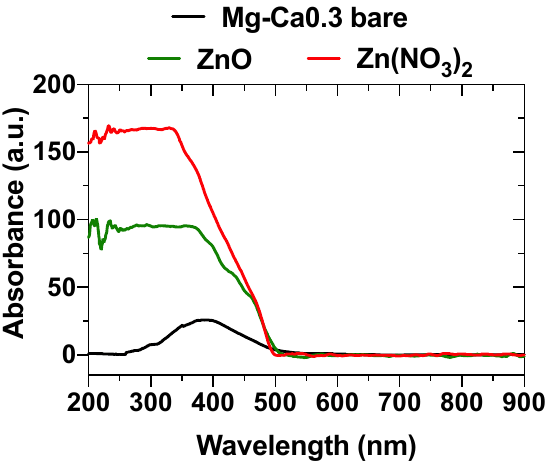
Figure 7. UV-Vis spectra of Mg–Ca0.3 surface and electroless ZnO deposits, obtained from aqueous suspension solutions (10 − 3 M, at 21 °C) and solutions of ZnO and Zn(NO 3 ) 2 .